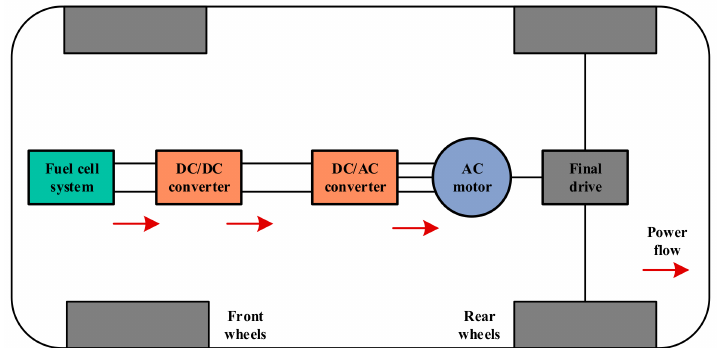
Figure 2. Full FCEV